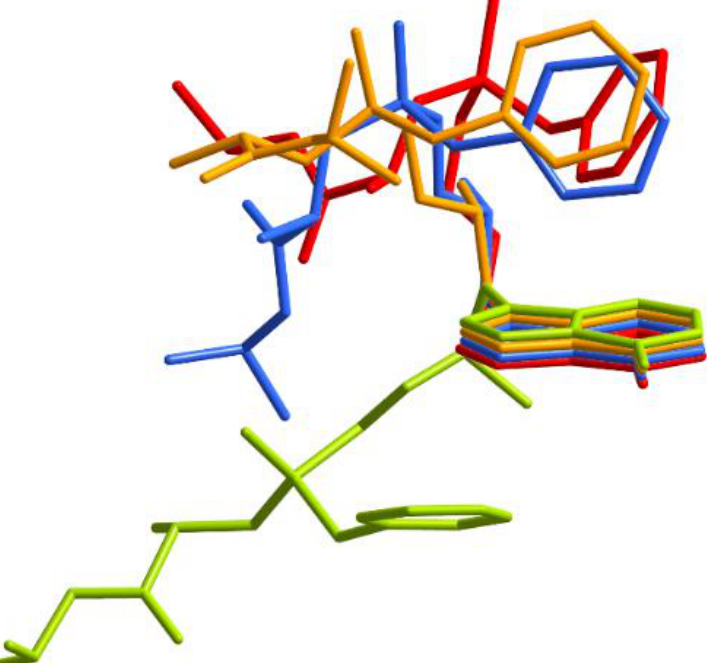
Figure 6. A superposition of the molecular conformations of the TAF moieties in their pristine form (red), 1 (light blue), and 2 (orange and lime), showing that one TAF in 2 exhibits drastically different conformations when compared to all the other forms. Int. J. Mol. Sci. 2020 , 21 , x FOR PEER REVIEW